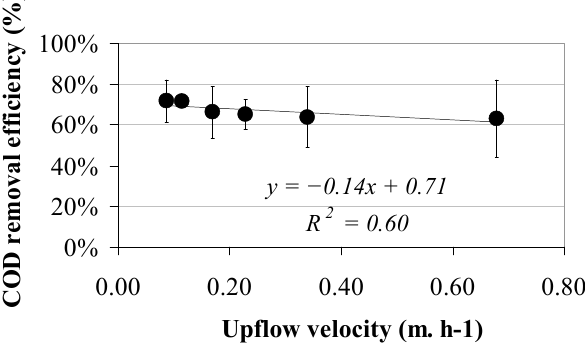
y = − 0.14x + 0.71 R 2 = 0.60